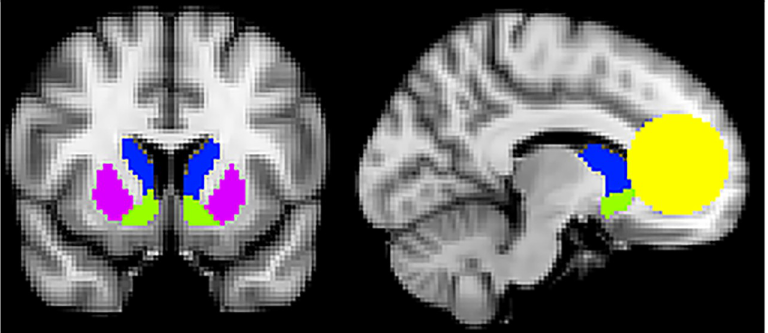
Fig 2. Regions of interest mask. Regions of interest were evaluated within an a priori mask encompassing caudate (blue), ventral striatum (green), putamen (purple), and medial prefrontal cortex